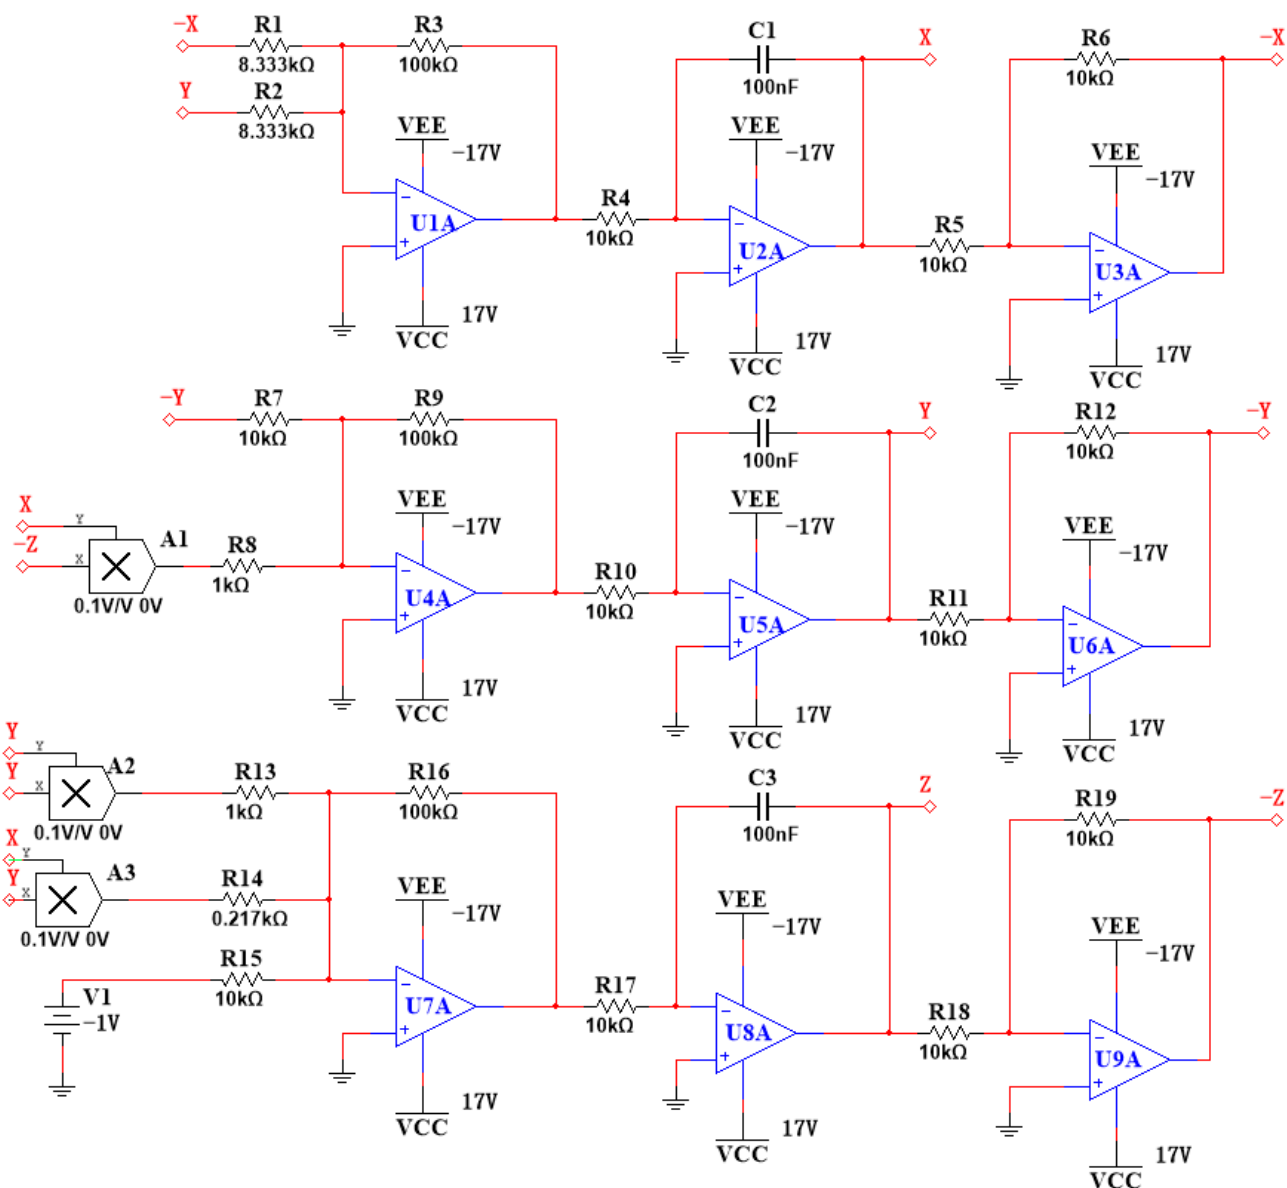
Figure 17. Circuit diagram of the new hidden attractor chaotic